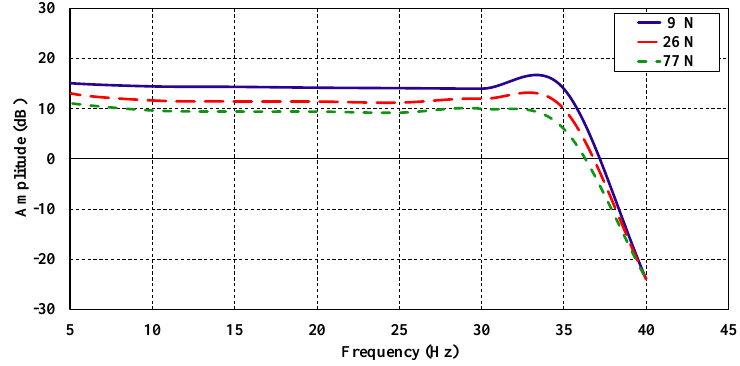
Figure 12. Dynamic response of the piezoelectric bimorph.